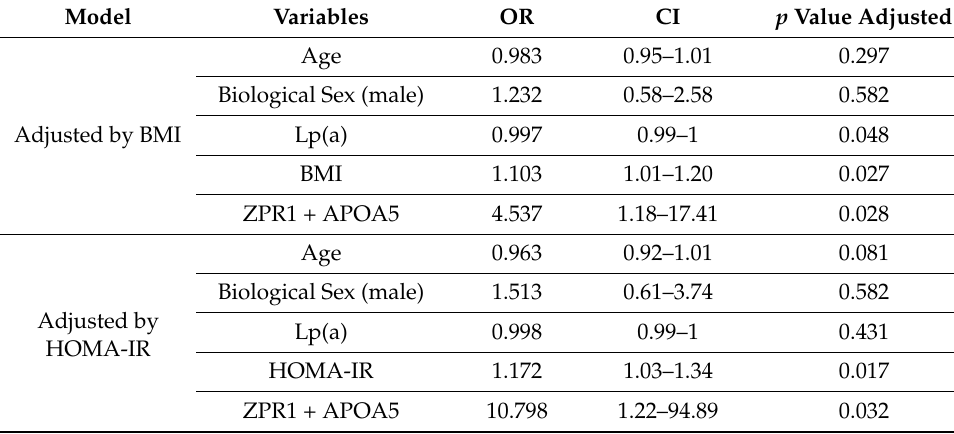
Table 3. Factors associated with non-alcoholic fatty liver